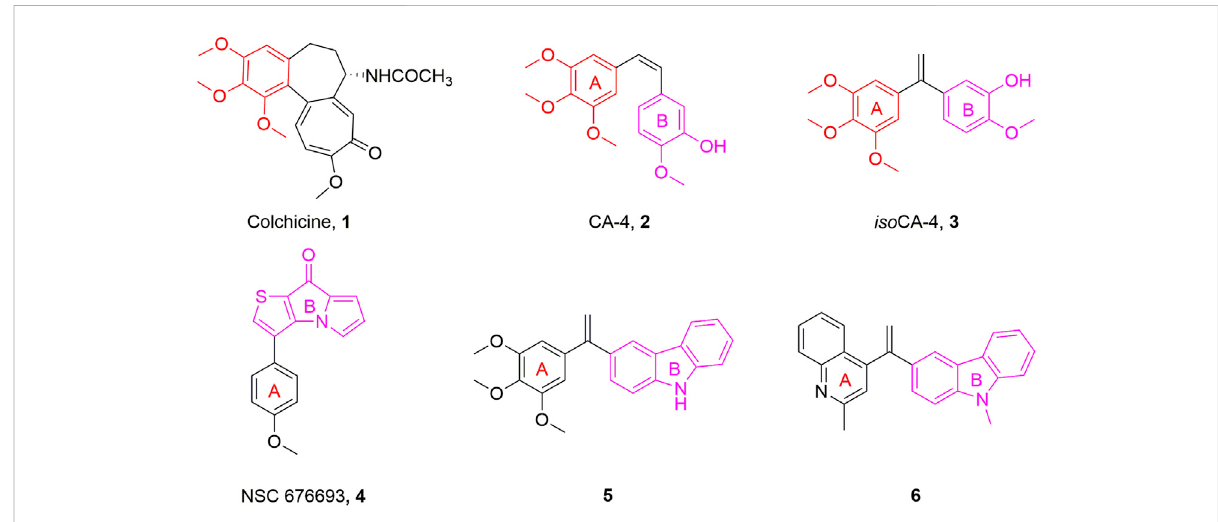
FIGURE 1 Chemical structures of some typical tubulin polymerization